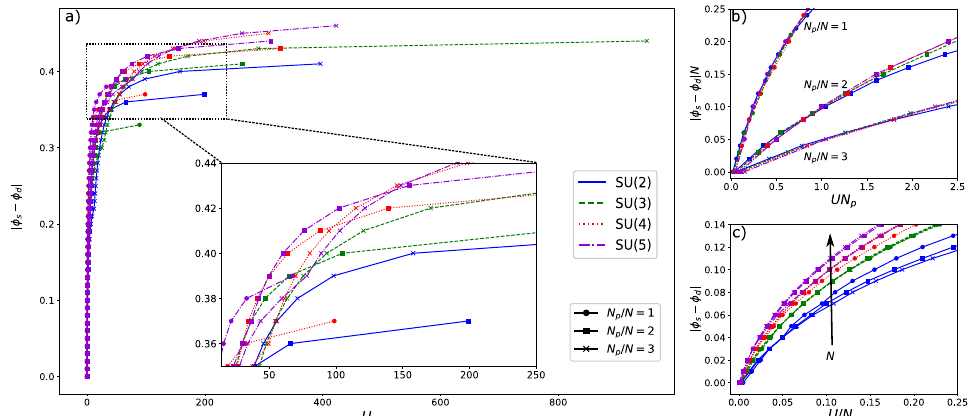
Figure 2: Figures of merit for spinon creation in the ground state of SU( N ) fermions. We consider the minimum value of U required for spinons to be created in the ground state for a given value of φ ; all the values of φ where a spinon is created are recorded. − φ | at which The displayed curves are calculated by monitoring all the distances | φ s d the state with no spinons crosses states with any spinon states, where φ is the flux s at which spinons are created and φ is the degeneracy point (see Fig. 1). a) Spinon d − φ | against interaction U . The inset contains the data creation flux distance | φ s d in the intermediate U regime. b) Spinon creation flux distance against the interac- tion, rescaled by N and N respectively, in the limit of low UN . In this limit, spinon p p / N c) Spinon creation flux dis- production is found to be a universal function of N p − φ | against interaction per particle U / N tance | φ in the low U / N regime. One s d p p can observe the enhancement of spinon production with increasing N . All the pre- sented results are obtained by BA of Gaudin-Yang-Sutherland model for L = 40, with = 1(circles), 2(squares), 3(crosses) per spin component, with N = 2,3,4,5. Thus, N p the dilute limit of the Hubbard model (1) is